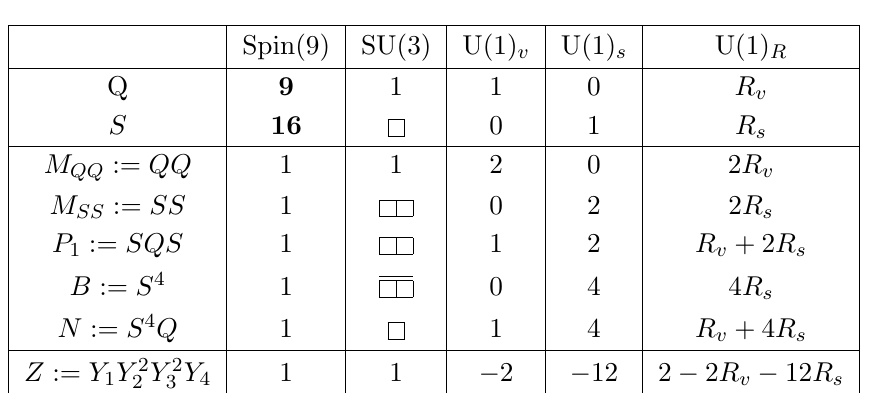
Table 8 . 3d N = 2 Spin(9) theory with ( N v ; N s ) = (3 ; 2).